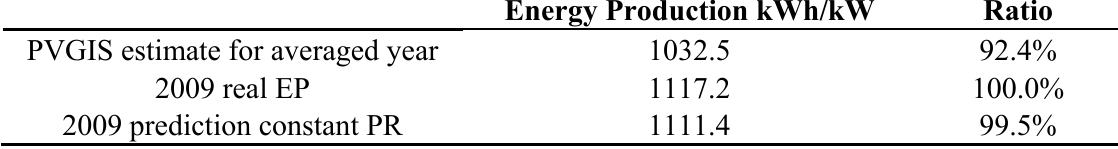
Table 3. January to July PVGIS EP estimate for an average year, real EP in 2009, and predicted EP for 2009 using constant PR, for the Écija CPV in